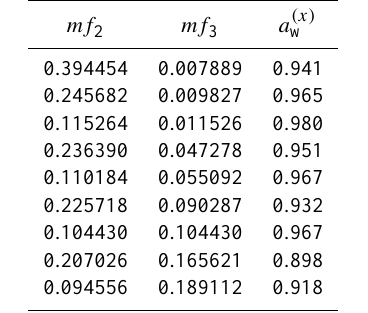
Table A3. Bulk water activity measurements of the system